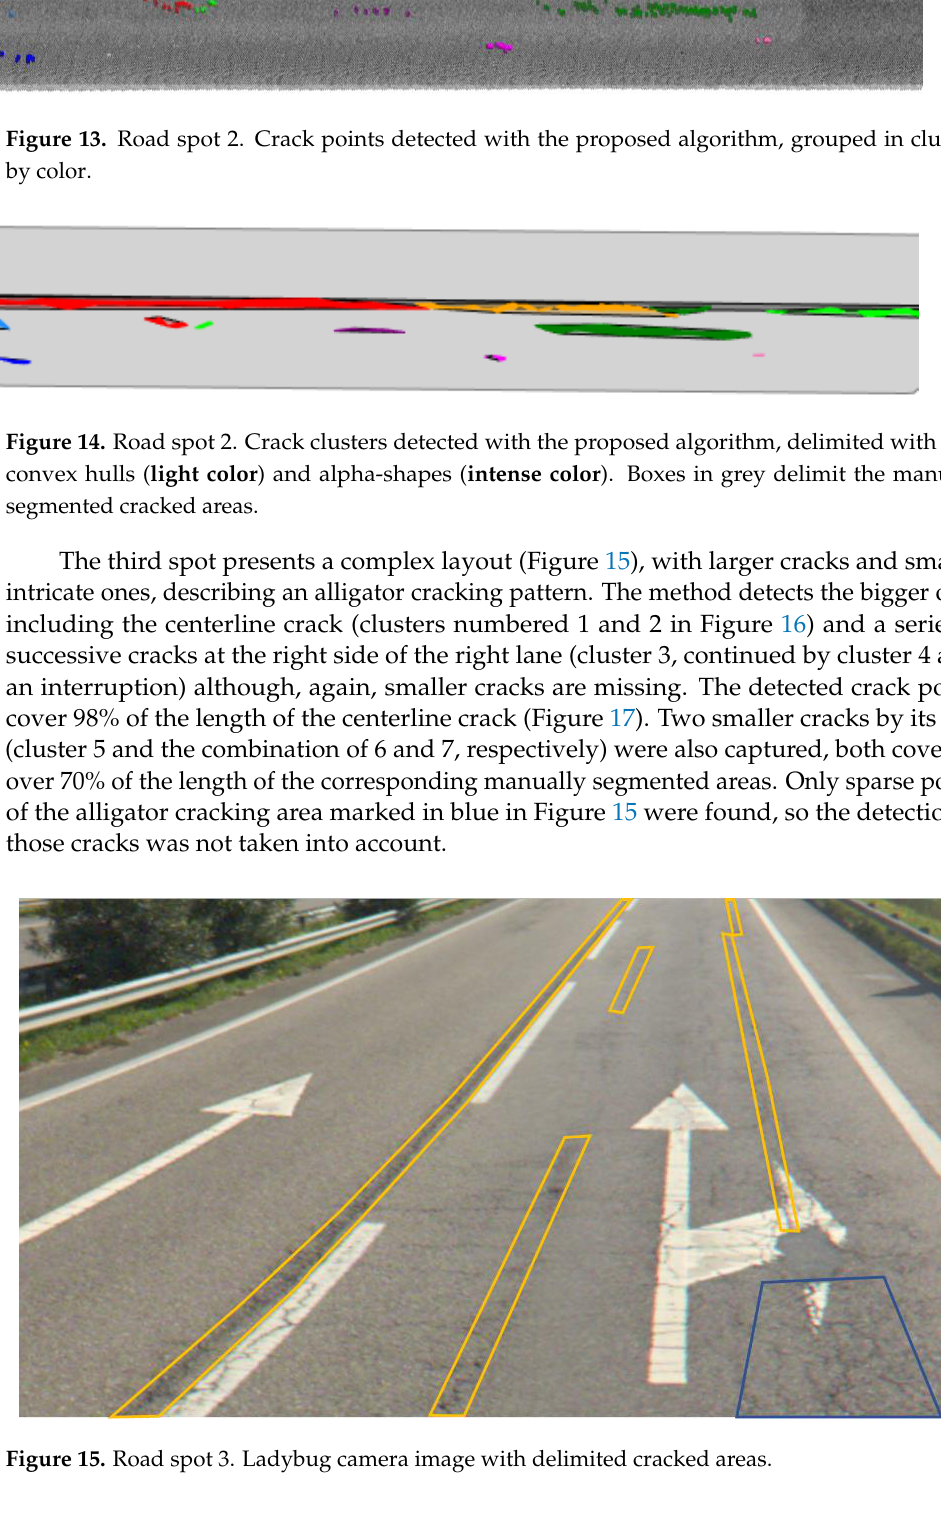
Figure 16. Road spot 3. Crack points detected with the proposed algorithm, grouped in clusters by color. Figure 17. Road spot 3. Crack clusters detected with the proposed algorithm, delimited with both convex hulls ( light color ) and alpha-shapes ( intense color ). Boxes in grey delimit the manually seg- mented cracked areas. The last spot presents a repaved area that interrupts the centerline crack, and a big, wide crack crossing the road diagonally (Figure 18) produced by the separation of the deck of the road at that point. The severity of the centerline crack is reduced in this part of the road, being merely visible in the images at some points and completely interrupted once the road reaches the repaved area. The proposed algorithm can capture this, recog- nizing only the most severely affected areas, as can be observed in Figure 19, with clusters number 1 and 2 representing the visible part of the crack before and after the repaved section of the road, respectively. A narrower crack on the right lane was not captured by the algorithm. The detected diagonal crack (cluster 3) covers 79% of the segmented area (Figure 20).